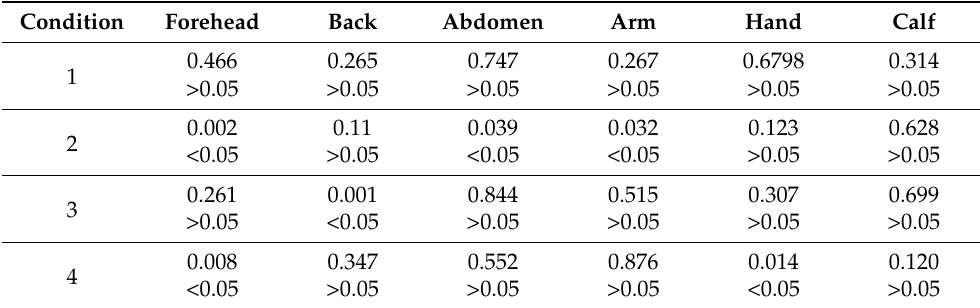
Table 5. Mann–Whitney U test of local thermal sensation vote in preschool children and young adults.